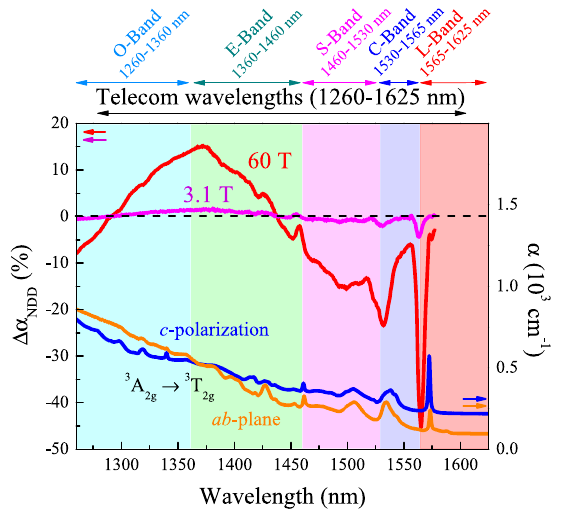
Fig. 4 Nonreciprocity at telecom wavelengths. Close-up view of nonreciprocal directional dichroism in Ni 3 TeO 6 on a percentage basis as a function of wavelength in the toroidal con fi guration at 4.0 K. Δ α NDD is shown at 3.1 and 60 T. The absolute absorption spectrum is included for comparison. Various commercial telecom windows are summarized on the upper axis. The U-band (1625 – 1675 nm) is not